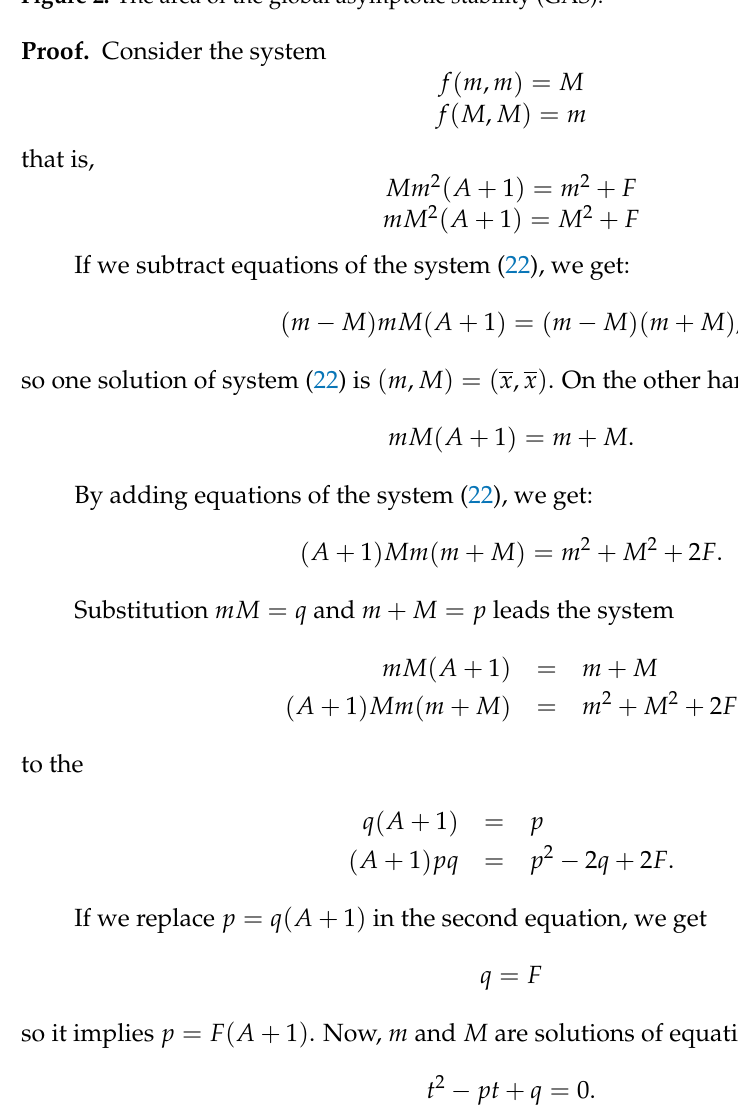
Figure 2. The area of the global asymptotic stability